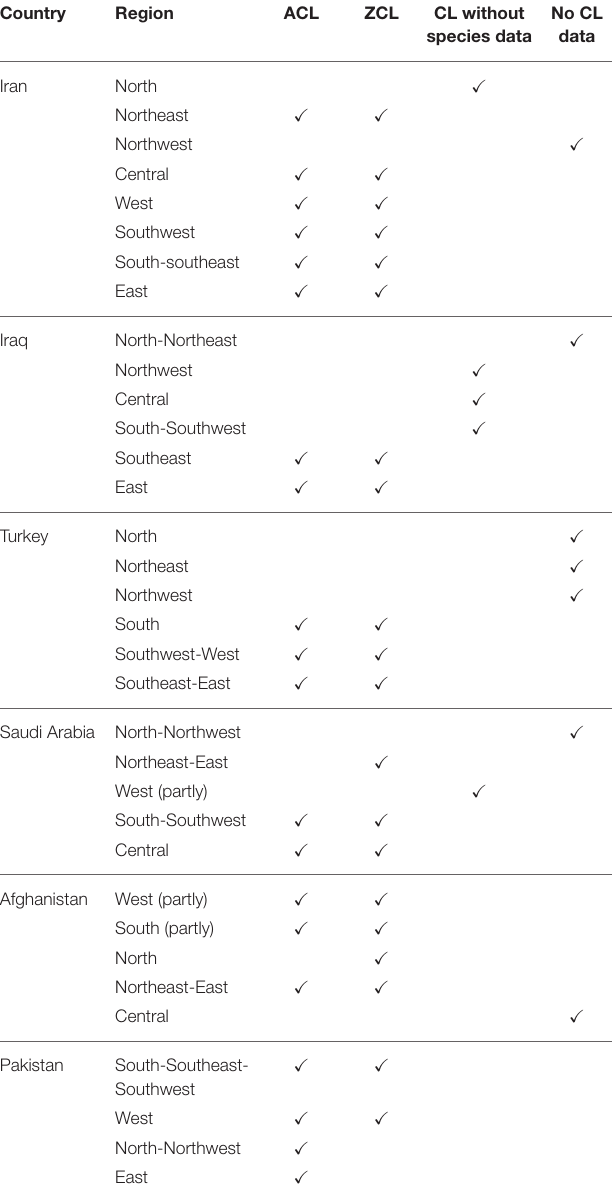
TABLE 1 | Distribution of ACL and ZCL in different geographical parts of studied